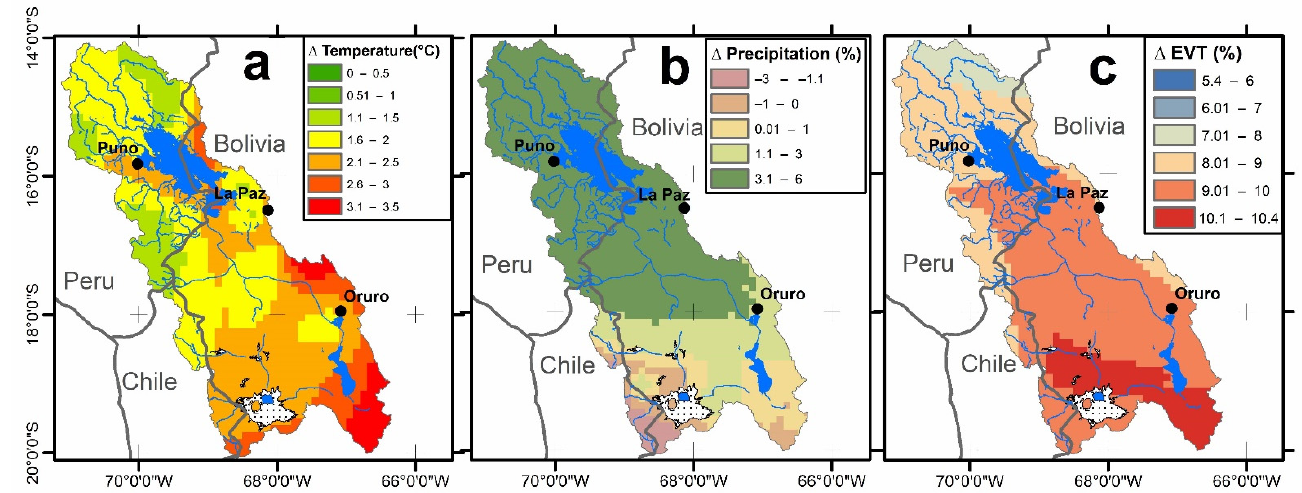
Figure 7. Changes in ( a ) mean temperature ( ◦ C), ( b ) mean annual precipitation (%), and ( c ) mean annual evapotranspiration (%) for the 2034–2064 period, relative to the 1984–2014 period.